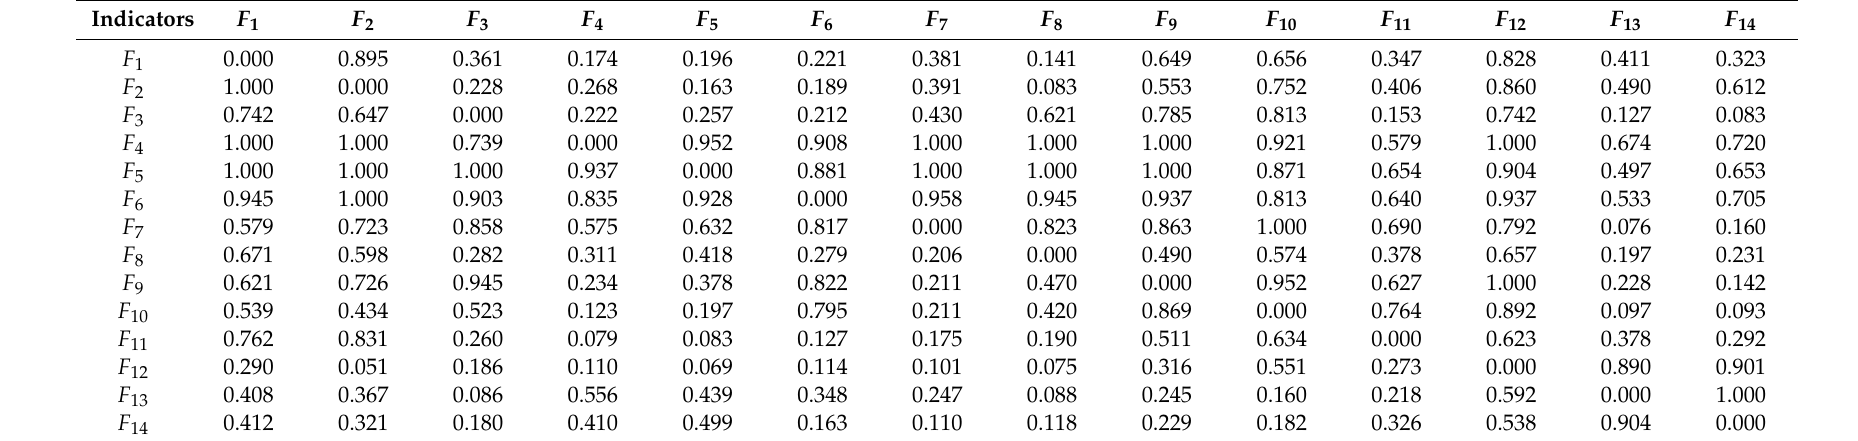
Table 4. The direct influencing matrix Z .